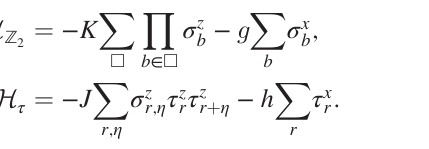
FIG. 1. (a) Lattice model of orthogonal fermions coupled to an Ising-Higgs lattice gauge theory. The matter fields f τ z (red circle) reside on the square lattice sites, and the Ising gauge field σ z r phase diagram of our model [Eqs. (2) and (3)] as a function of the hopping amplitude t and transverse field g . The phase boundaries are determined by the location of the confinement transition and emergence of c fermions spectral weight; see the main text. Connecting lines are guides to the